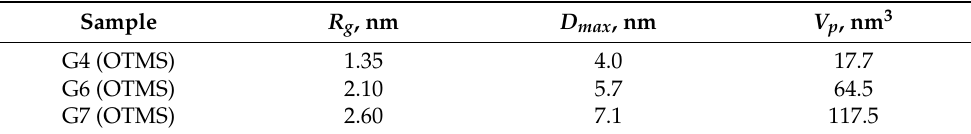
Figure 6. Small angle X-ray scattering (SAXS) patterns of the 4th (1), 6th (2), and 7th (3) genera- tions of carbosilane-siloxane dendrimers. The experimental data are shown as dots with error bars, scattering from the MD models as solid lines. Table 3. Overall structural parameters obtained by SAXS. Table 3. Overall structural parameters obtained by SAXS.